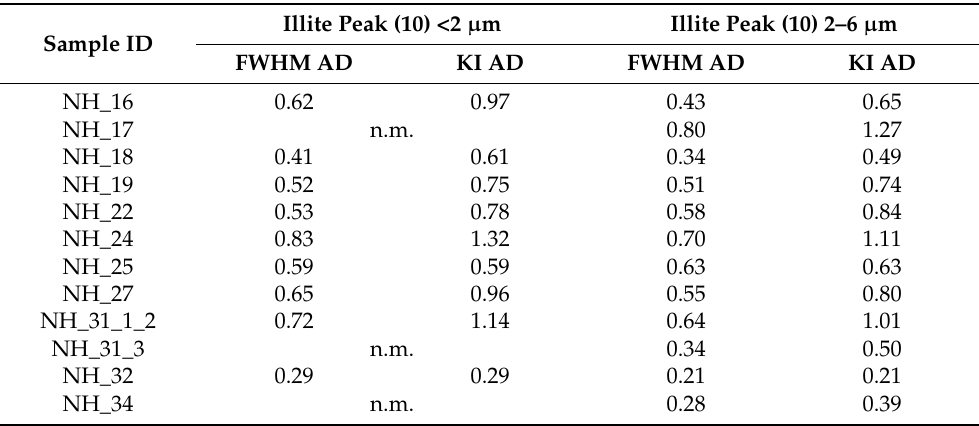
Table 6. List of samples with their respective FWHM and Kübler Index (KI) values in air-dried